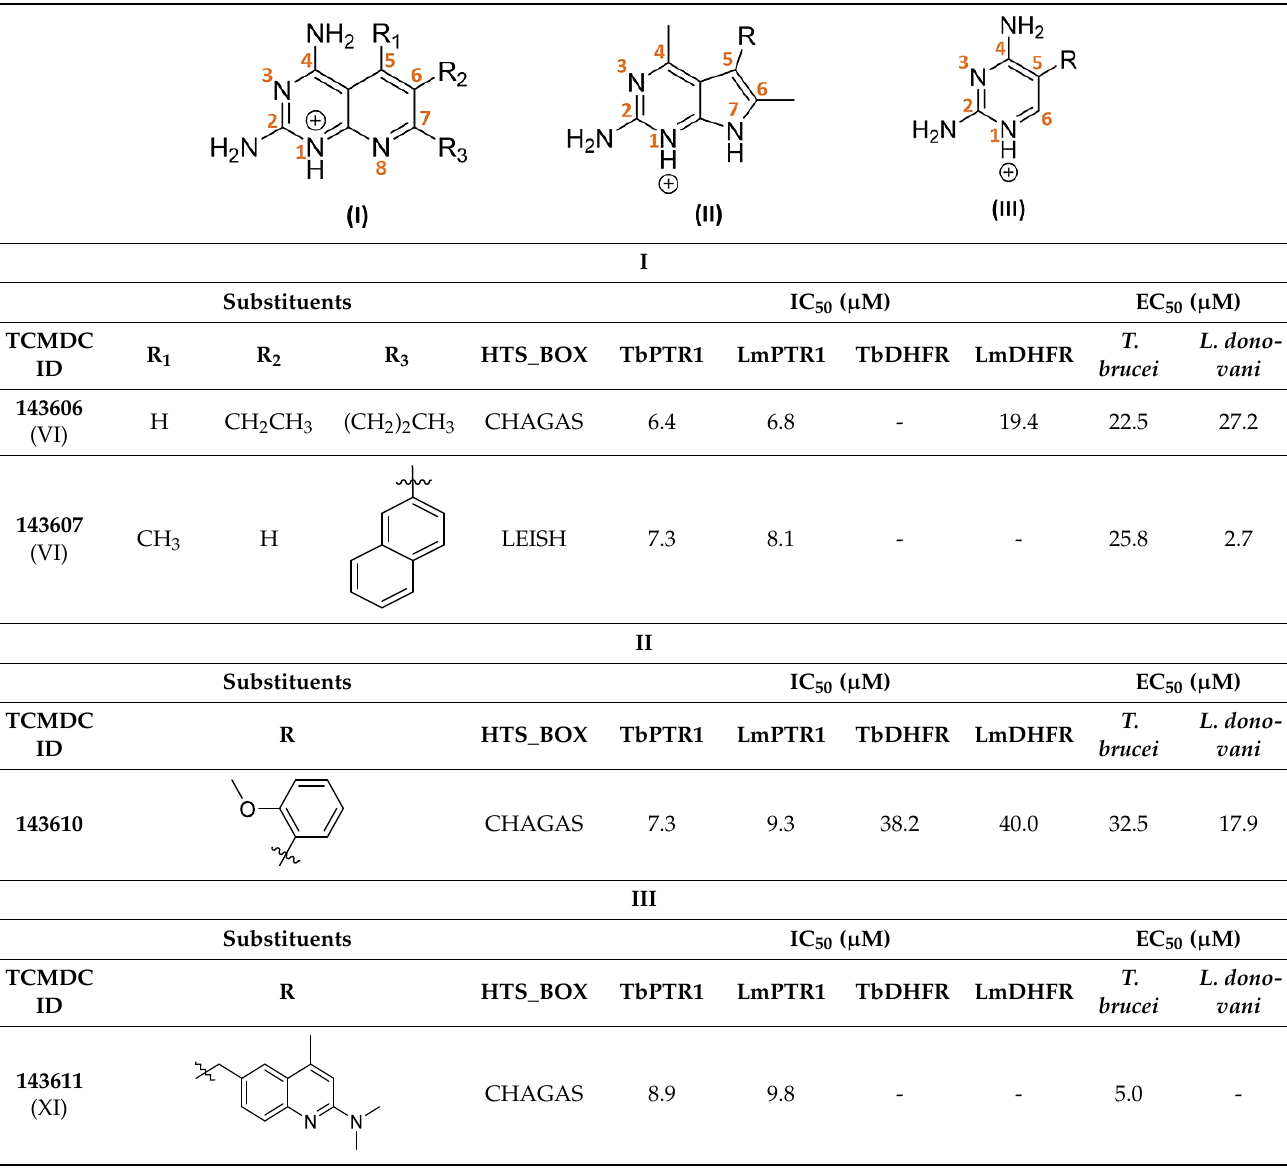
Table 3. Pyrido-pyrimidine ( I, cluster VI ), pyrrolo-pyrimidine ( II ) and pyrimidine ( III, cluster XI ) derivatives.